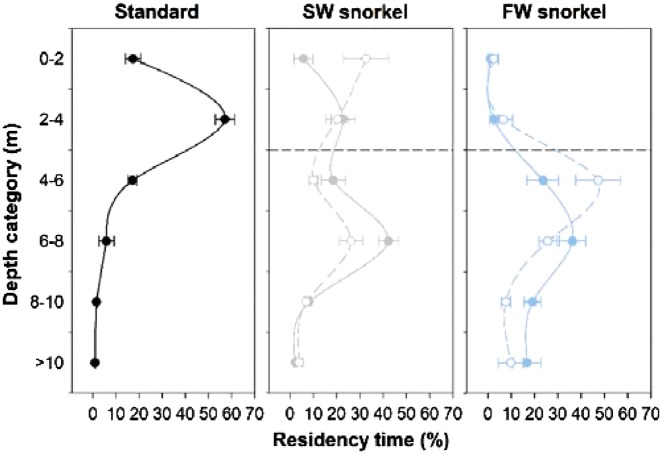
Mean ± SE proportions of times tagged salmon swam in 2 m depth intervals among individuals in standard (left, black), SW snorkel (middle, grey), and FW snorkel fish (right, blue lines). Solid and dotted lines represent depths of surviving and dying individuals, respectively. Data were pooled from 1 day post-release between 18–20 January and 30 January 2017.